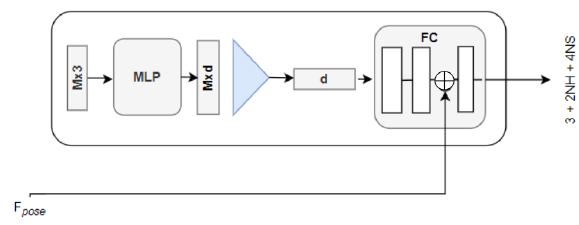
Figure 6. Bounding box estimation module with pose fusion The 3D amodal bounding box estimation module uses these ex- tracted point features along with the F pose and applies a T-Net (Figure 6) to infer the coordinates of the 3D bounding box of the object. The loss functions used in the network are the same as proposed in